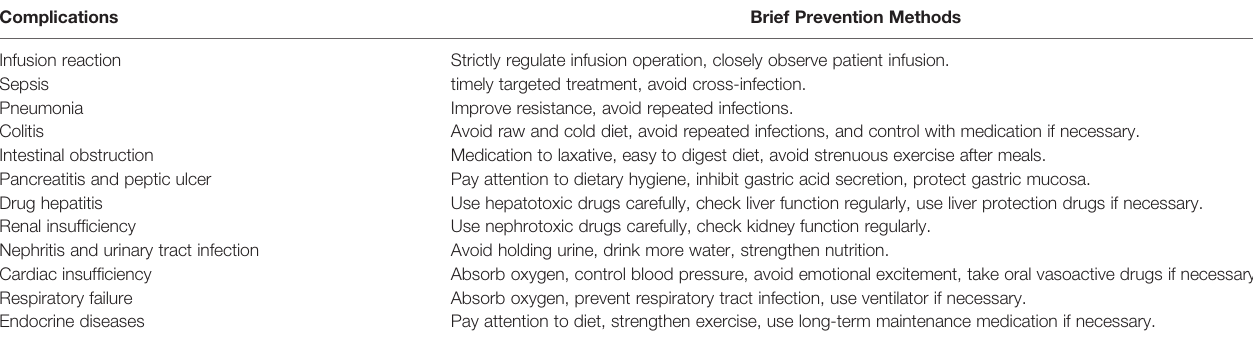
TABLE 2 | List of serious complications and brief prevention methods for bladder